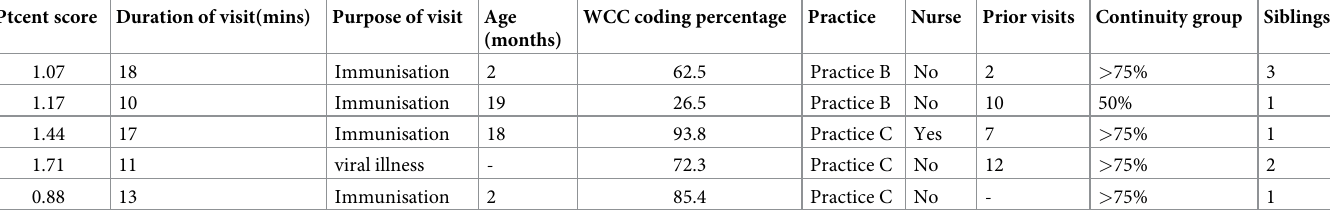
Table 6. Characteristics of GP visits with higher patient centeredness scores and well child care activities. Ptcent score Duration of visit(mins) Purpose of visit Age